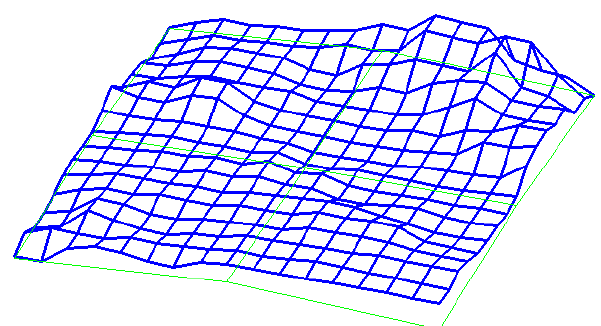
Figure 11. Virtual ground surface including the adjacent course